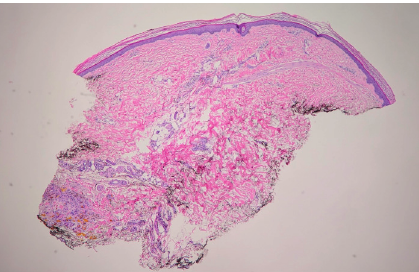
Figure 2: Low-power magnification shows widely dispersed der- mal pigmentation and an epidermis with no significant pathologic changes (20x; hematoxylin and eosin staining).